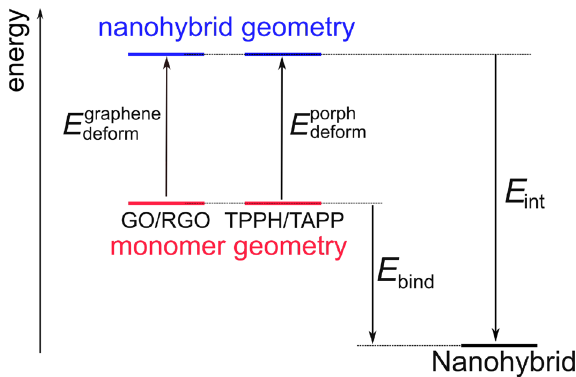
Figure 6. Binding energy ( E bind ) decomposition scheme used to break down the energetic effect of the nanohybrid formation into three energetic components: geometric deformation of the substrates, E E porph deform as well as interaction energy of the deformed substrates (